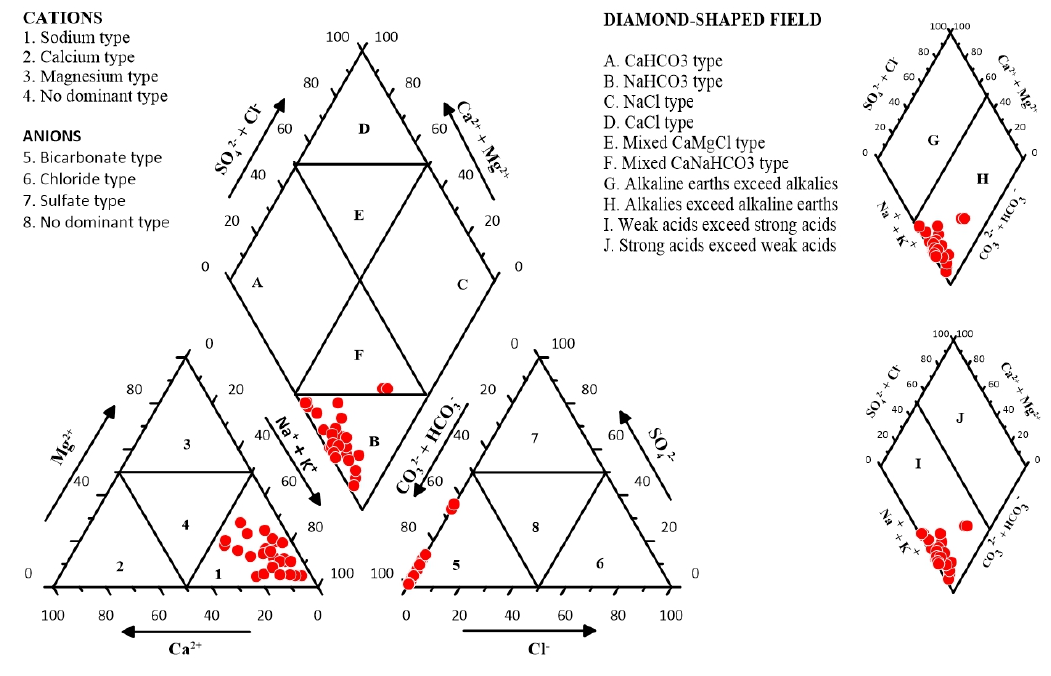
Figure 3. Piper diagram of groundwater samples in the study area showing diamond-shaped subdivisions.